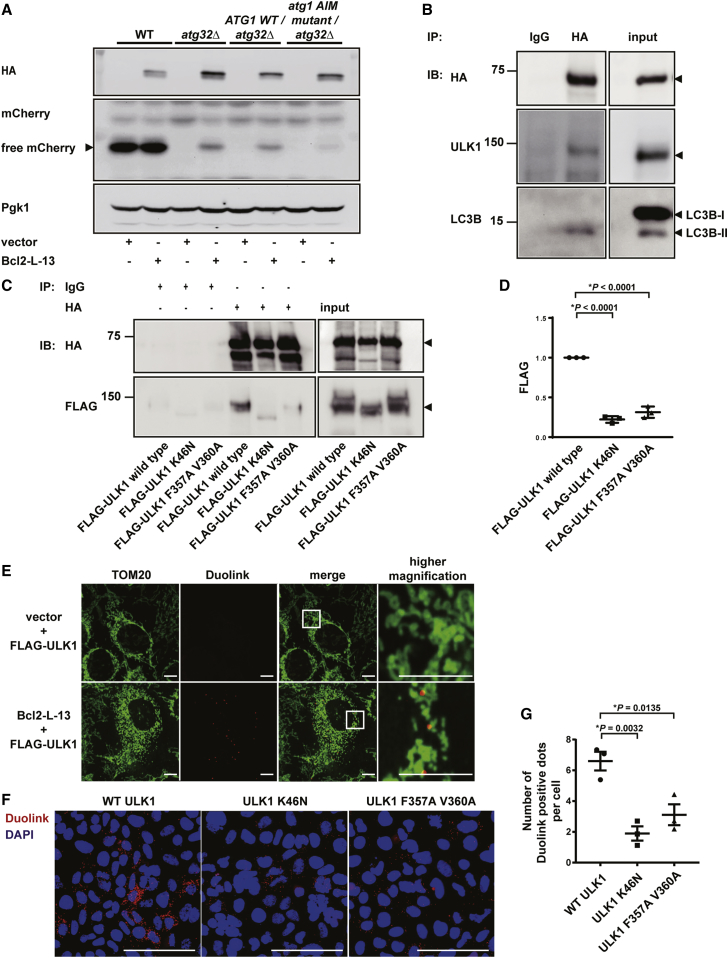
ULK1-LC3B (Atg1-Atg8) Interaction through the LIR (AIM) Motif Is Important for Bcl2-L-13-Mediated Mitophagy(A) The atg32Δ yeast cells expressing wild-type Atg1 (ATG1 WT/atg32Δ) and AIM mutant of Atg1 (atg1 AIM mutant/atg32Δ) transfected with HA-Bcl2-L-13 or empty vector were collected 72 hr after mitophagy induction in SD-G medium.(B) Forty-two hours after transfection with HA-Bcl2-L-13, HEK293A cells were treated with pepstatin A and E64d for 4 hr and immunoprecipitated with anti-HA antibody. Co-precipitated endogenous ULK1 and LC3B were detected by immunoblotting.(C and D) Forty-eight hours after transfection with HA-Bcl2-L-13 and FLAG-tagged wild-type ULK1 or ULK1 mutants, HEK293A cells were immunoprecipitated with anti-HA antibody. Precipitates were immunoblotted with FLAG antibody. Densitometric analysis of the band for FLAG is shown in (D). The value for FLAG-ULK1 wild-type transfected cells in each experiment was set equal to 1 (n = 3). ∗p < 0.05. Results are shown as mean ± SEM.(E) Proximity ligation assay. HEK293A cells were transfected with FLAG-ULK1 and empty vector or HA-Bcl2-L-13. After 48 hr of transfection, cells were fixed and stained with Duolink and an anti-TOM20. Scale bar : 10 μm.(F and G) After 48 hr of transfection with HA-Bcl2-L-13 and FLAG tagged wild-type ULK1 or ULK1 mutants, HEK293A cells were stained with Duolink and DAPI. For each experiment, signals from 18 view fields (1674 to 2772 cells) were quantified (n = 3). The number of Duolink positive dots per cell is shown in (G). Scale bar: 100 μm. ∗p < 0.05. Results are shown as mean ± SEM.See also Figure S3.